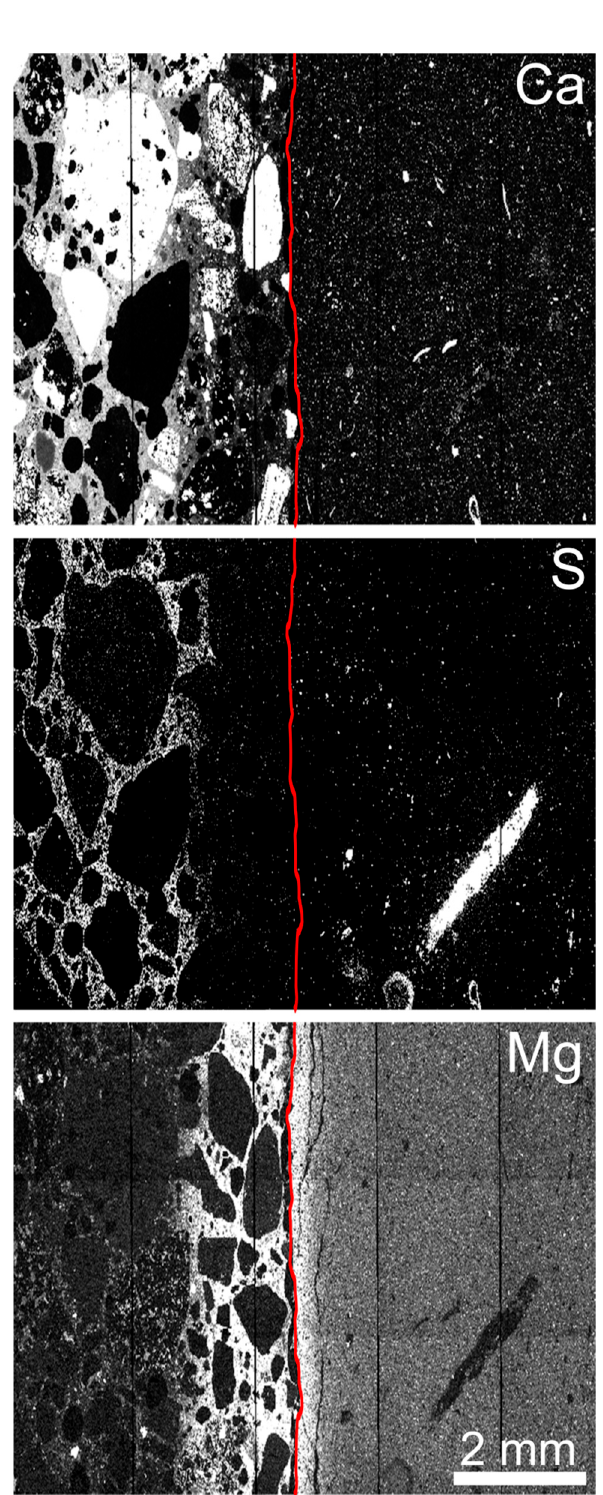
Figure 6. SEM EDX element maps of 4.8 y ESDRED-OPA interfaces, concrete on the left, OPA on the right of the interface marked in red. Bright areas represent high concentrations of the element indicated. On the concrete side, only the cement matrix between the aggregates is relevant. OPA contains pyrite (high S areas) and calcite (high Ca spots).